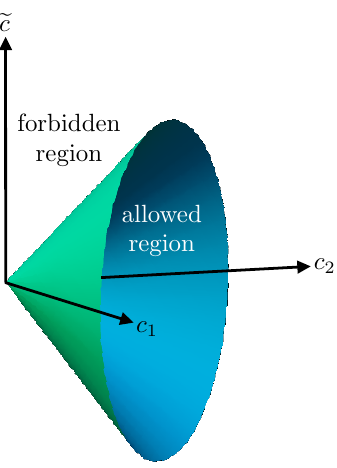
Figure 5 . General form of the bounds derived in section 4. CP-conserving terms (or linear combinations thereof) have coe(cid:14)cients c 1 and c 2 bounded to be positive, while the